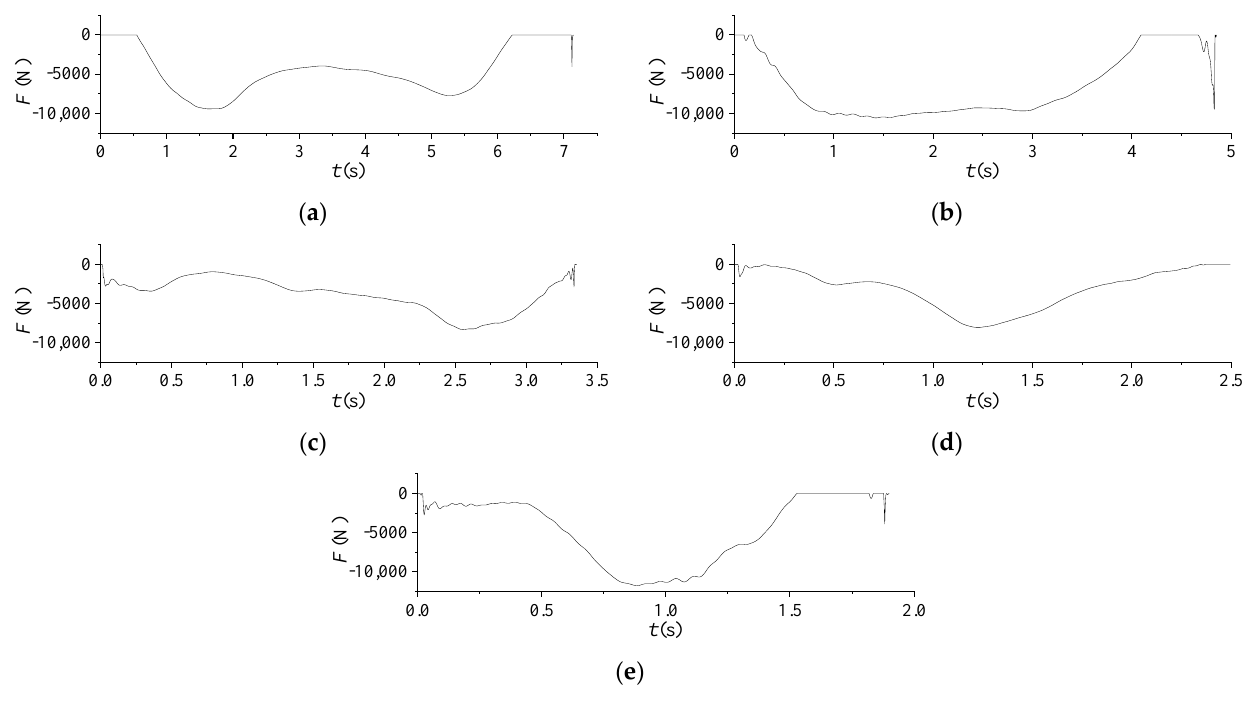
Figure 14. The contact force identification result of the 10 m span. ( a ) 5 km/h, ( b ) 10 km/h, ( c ) 15 km/h, ( d ) 20 km/h, ( e ) 25 km/h.